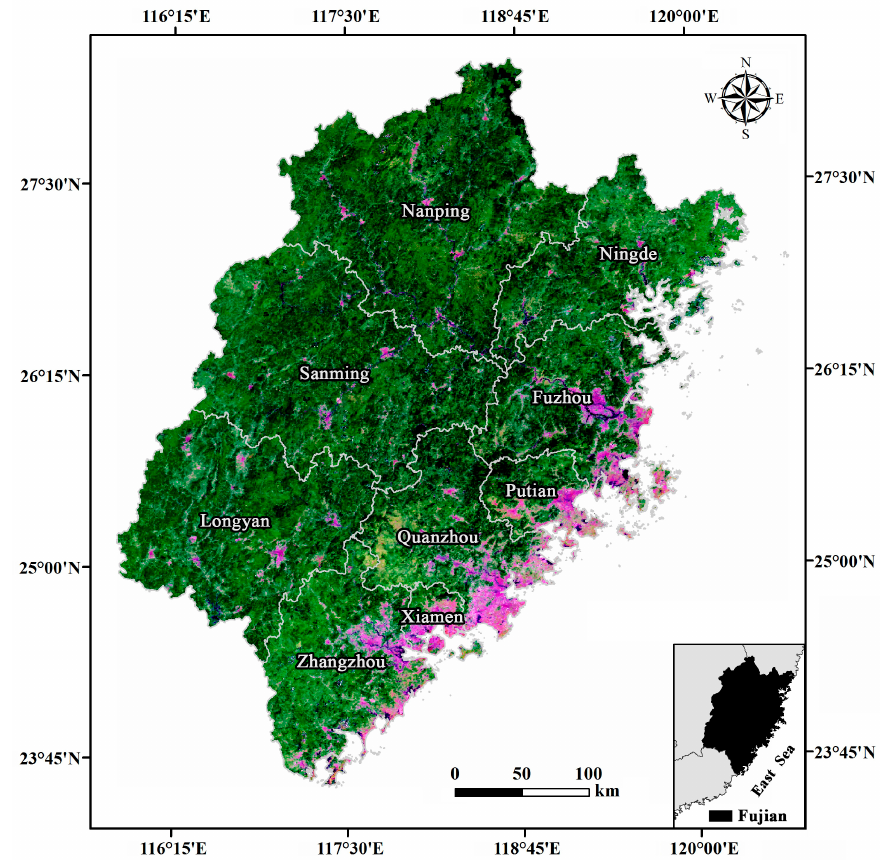
Figure 1. Location map of Fujian province and nine prefecture-level cities (2017 MODIS image) .